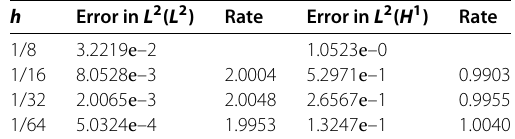
Figure 2 The numerical solution of u at t = 1.